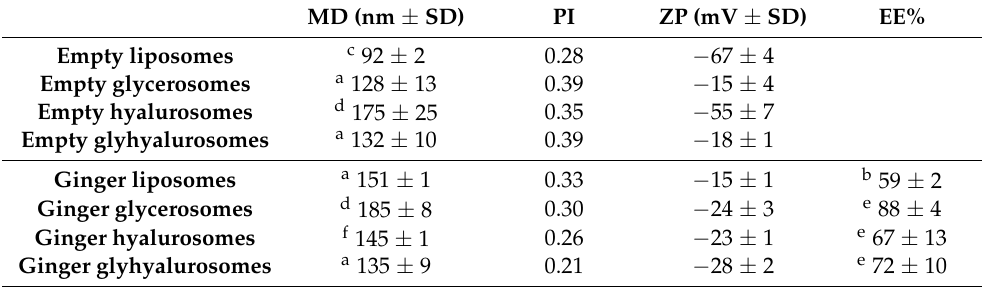
Table 1. Mean diameter (MD), polydispersity index (PI), zeta potential (ZP), and entrapment effi- ciency (EE) of the empty and extract loaded vesicles. Data represent the means ± SD of at least six replicates. Each symbol (a, b, c, d, e, f) indicates the same value of mean diameter ( p > 0.05). MD (nm ±